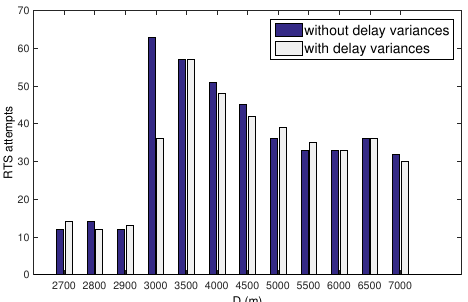
Figure 7. RTS attempts in different settings of the slot length.